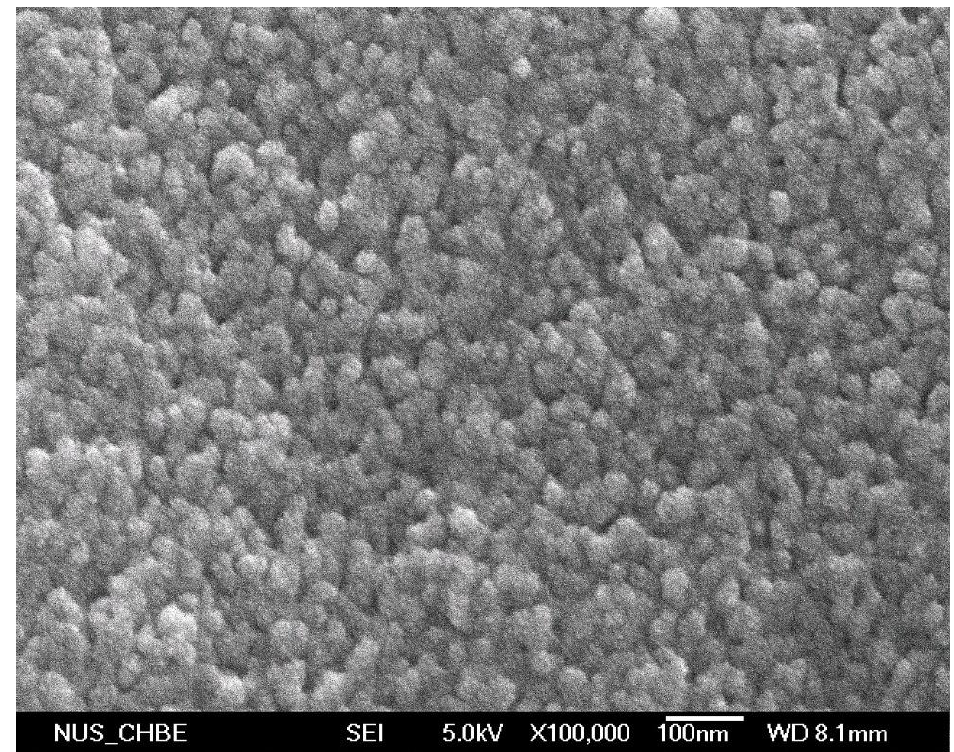
Figure A1. FE-SEM images of cross-linked diblock A50G4S-10 membrane (magnification 50,000×).